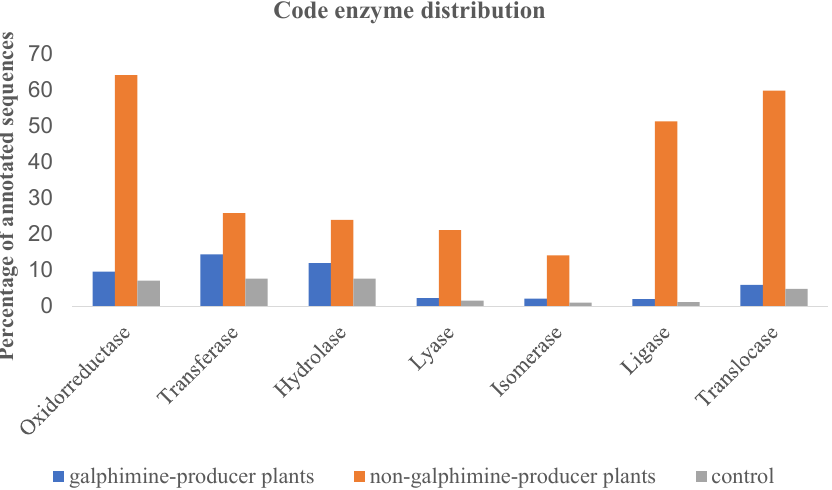
Figure 2. Enzyme distribution code of annotated sequences (percentage) in galphimine producer plants (leaves samples), non-galphimine producer plants (leaves samples), and control (roots samples).